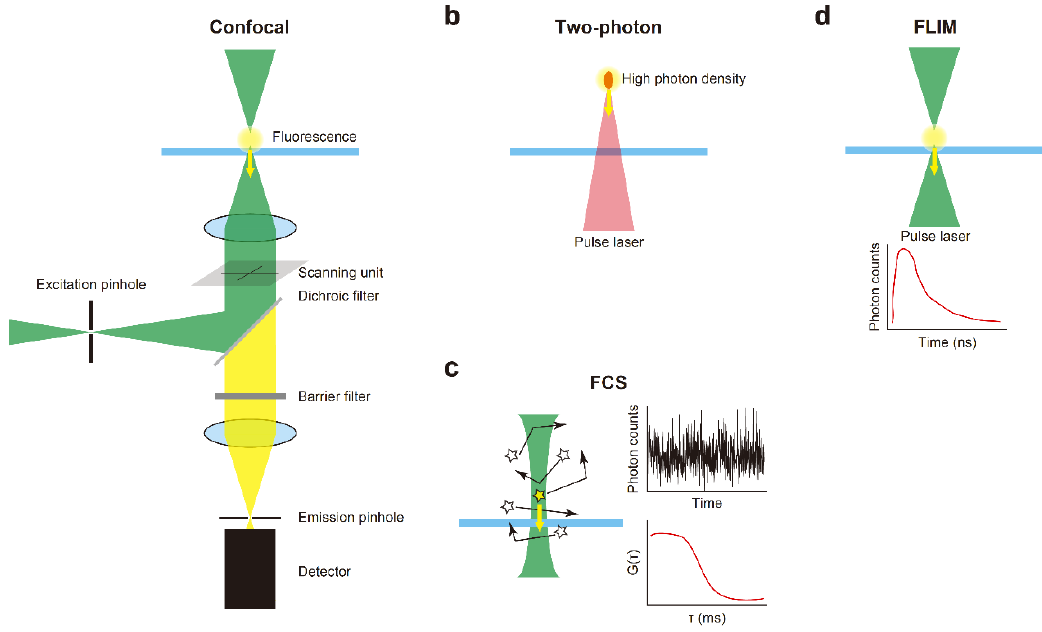
Figure 2. Schematics of confocal microscopy and fluorescence microscopy with confocal optics: ( a ) confocal microscopy; ( b ) two-photon microscopy; ( c ) fluorescence correlation microscopy (FCS); ( d ) fluorescence lifetime imaging microscopy (FLIM).